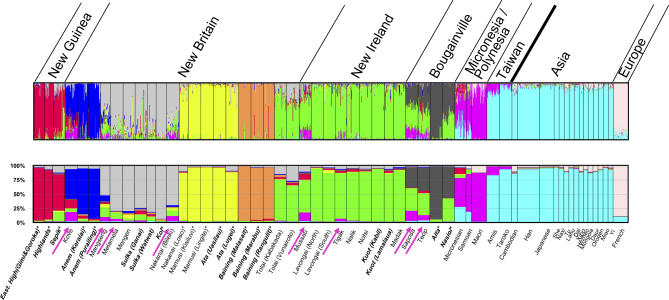
Pacific Population Structure DetailsIndividual and (below) mean population assignments at K = 10 for the Pacific, HGDP-CEPH East Asia, and French. Purple arrows denote the eight Oceanic-speaking populations with an “Austronesian” assignment signature above 5%. Papuan-speaking group names are in bold italics. Asterisks denote inland groups. Populations are arranged geographically, approximately from west to east.